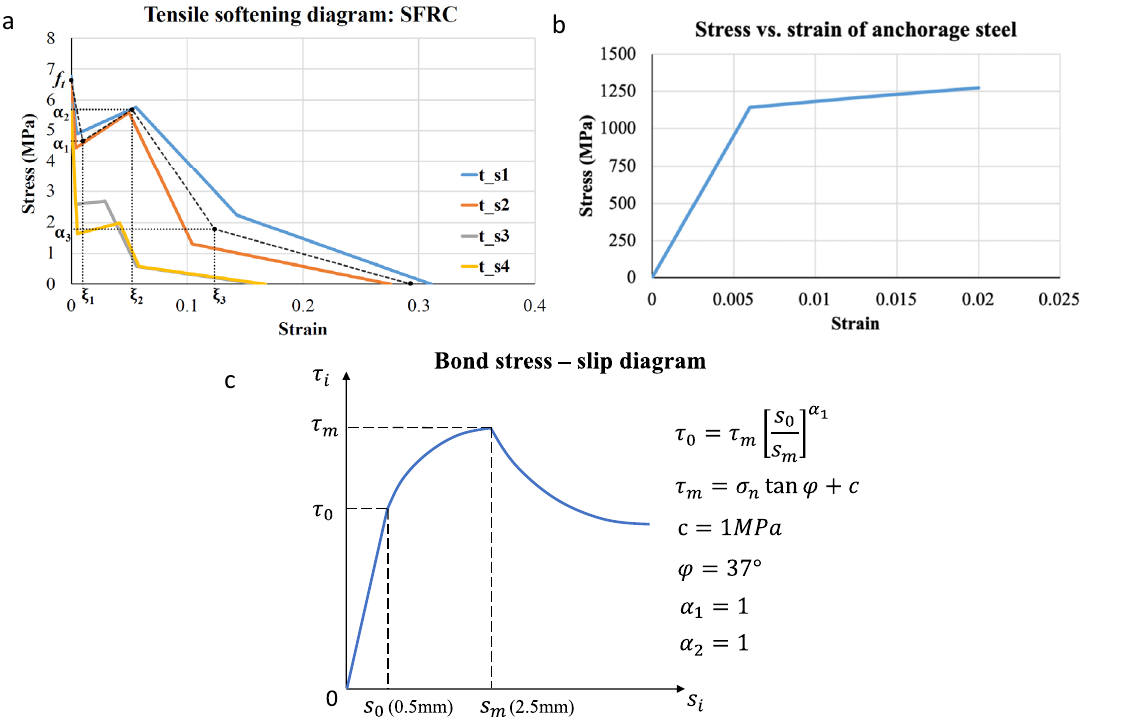
Figure 5. Numerical model: (a) Tensile strain softening diagram for SFRC with different orientation profiles; (b) Stress ‐ strain diagram of the steel cables and connectors (c) Interface bond stress ‐ slip diagram